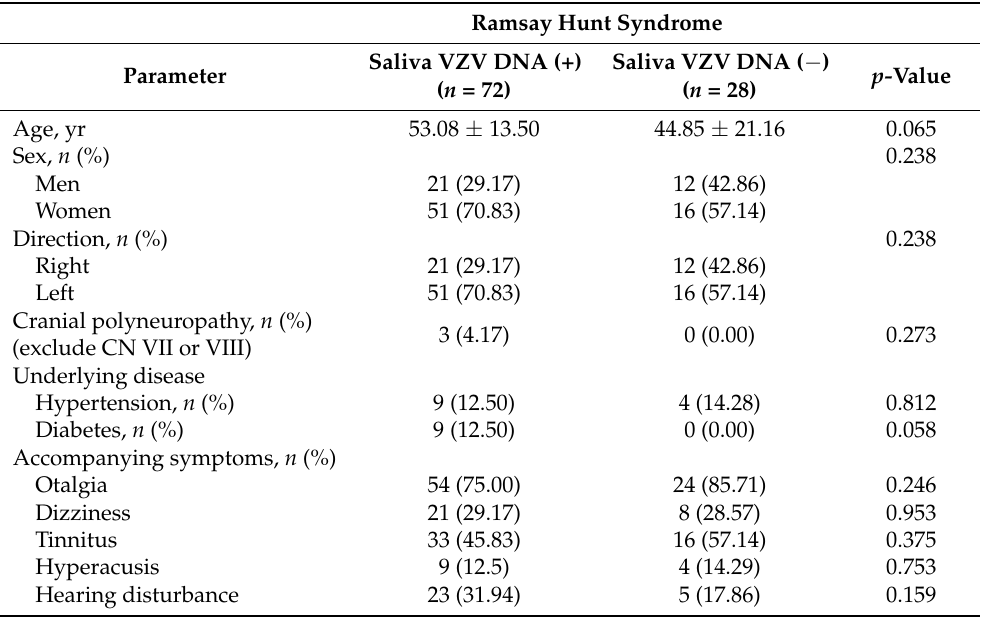
Table 1. Demographic information of patients with RHS according to presence or absence of salivary VZV DNA.